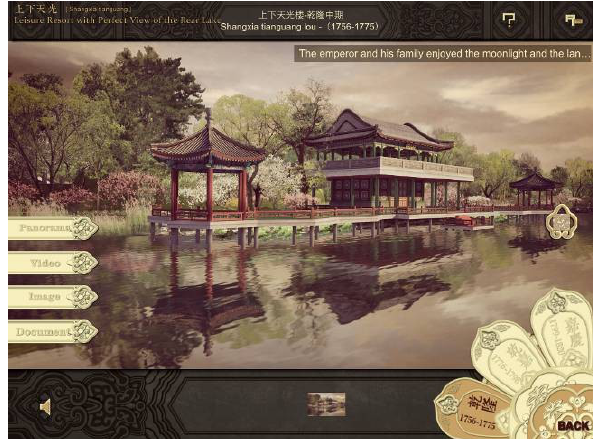
Figure 7. Rendered image of a corresponding site (Shangxia tianguang), showing an earlier state the monument (1756-1775)